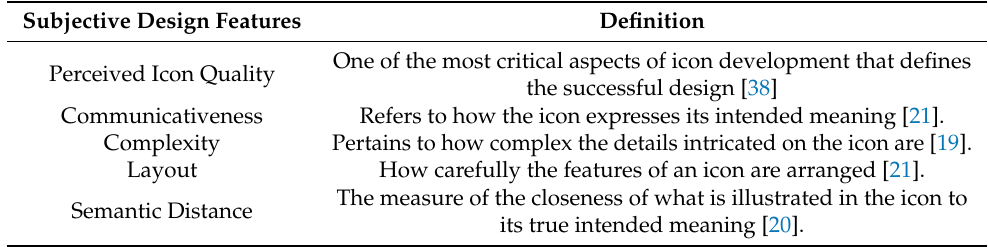
Table 4. Descriptions of subjective design features. Table 5. Semantic scales and their corresponding subjective design feature.